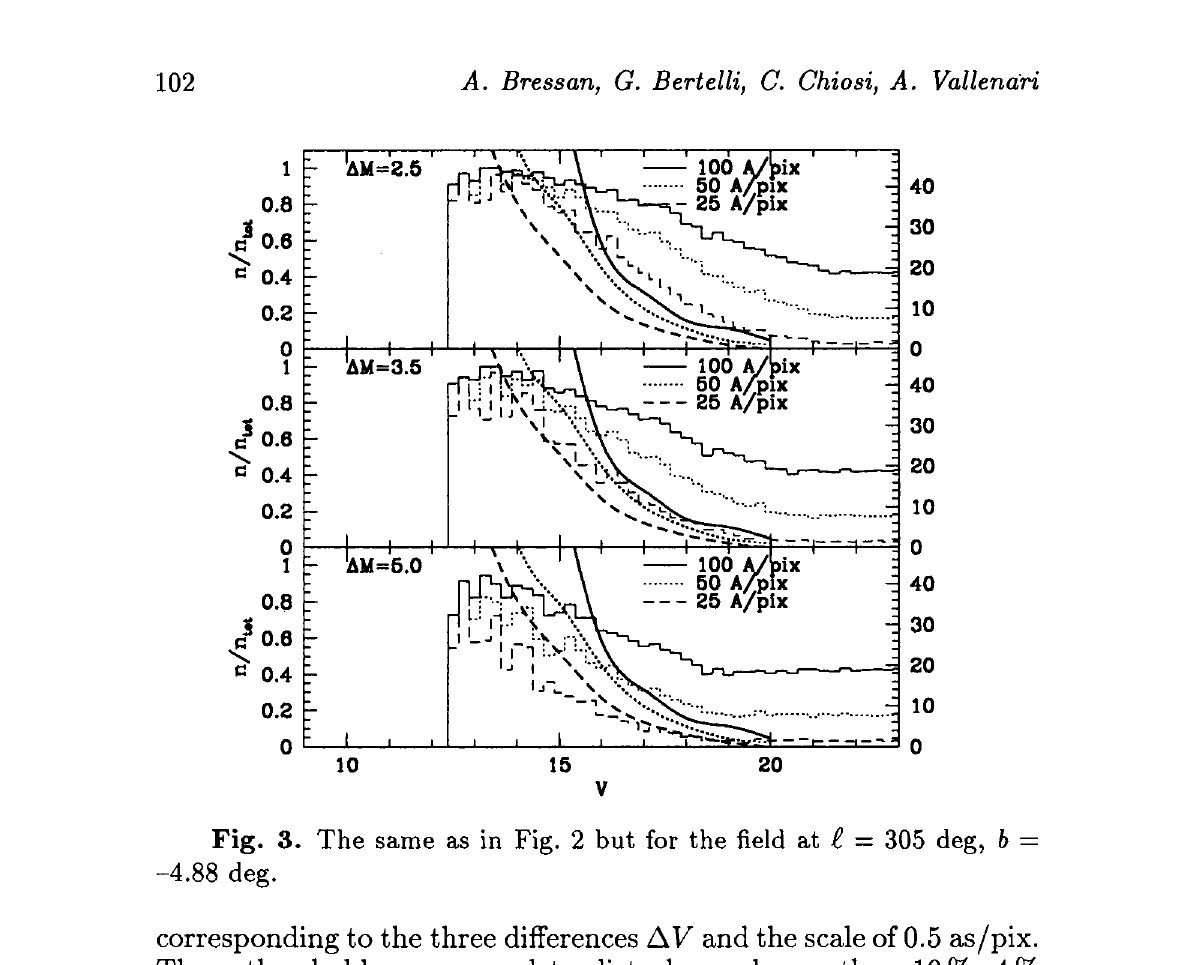
Fig. 3. The same as in Fig. 2 but for the field at I = 305 deg, b = -4.88